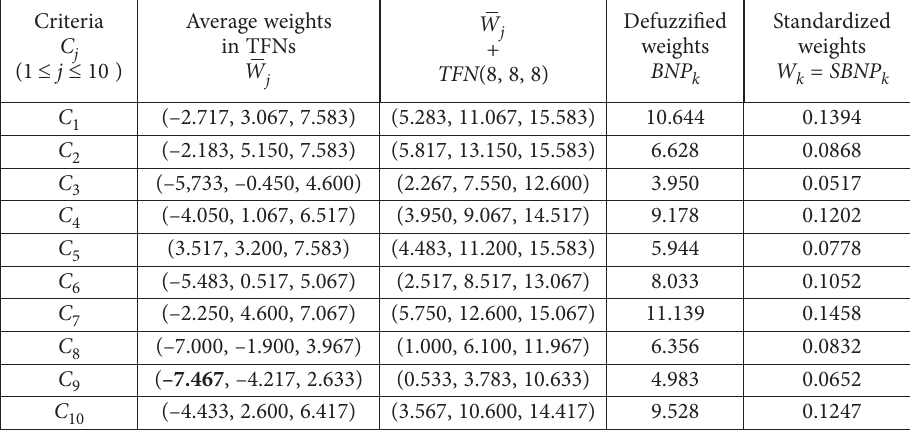
Table 5. The average fuzzy and defuzzification weights of 10 criteria